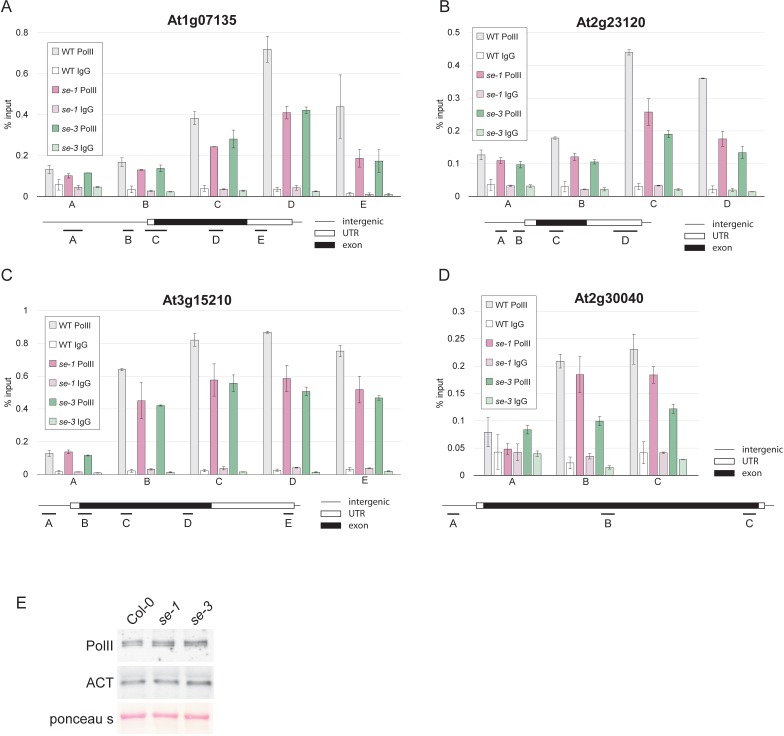
SE is important pol II association to its target genes, but does not affect pol II levels.(A–D) Analysis of pol II occupancy at SE target loci by pol II-ChIP qPCR in WT, se-1 and se-3. A general pol II antibody and mouse IgGs (as negative control) were used for immunoprecipitation. Error bars denote the range of two biological replicates. (E) Protein blot analysis of pol II levels in WT, se-1 and se-3 using pol II antibodies. ACTIN (ACT) served as a loading control.